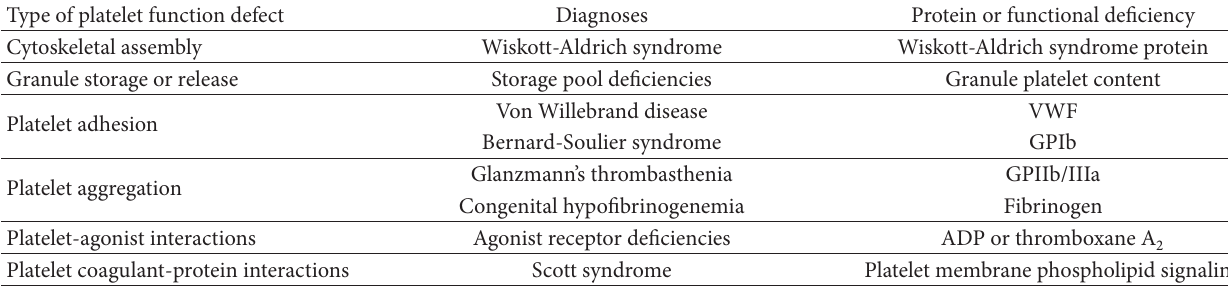
Table 1: Types of congenital platelet function